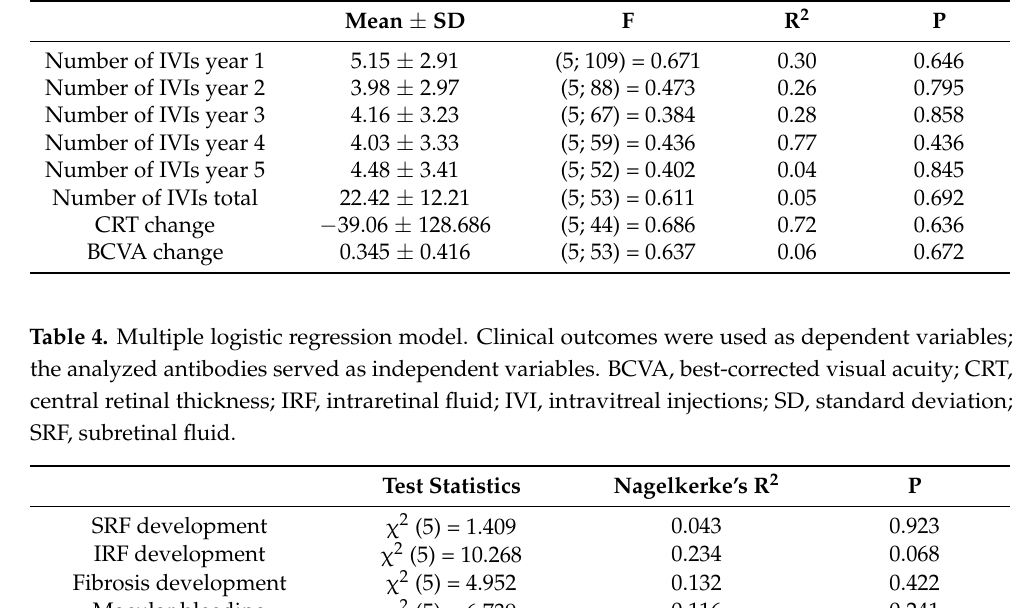
Table 3. Multiple linear regression model. Clinical outcomes were used as dependent variables; the analyzed antibodies served as independent variables. BCVA, best-corrected visual acuity; CRT, central retinal thickness; IVI, intravitreal injections; SD, standard deviation.